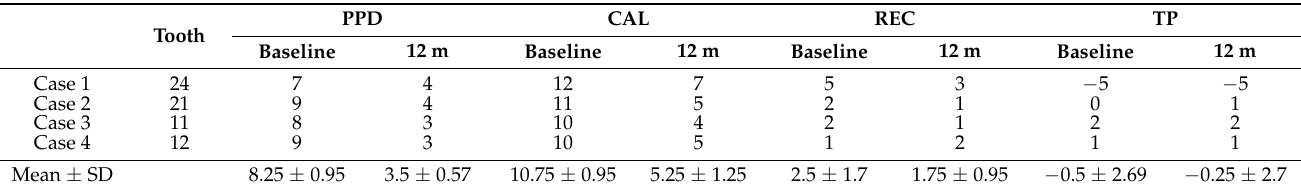
Table 1. Clinical parameters.